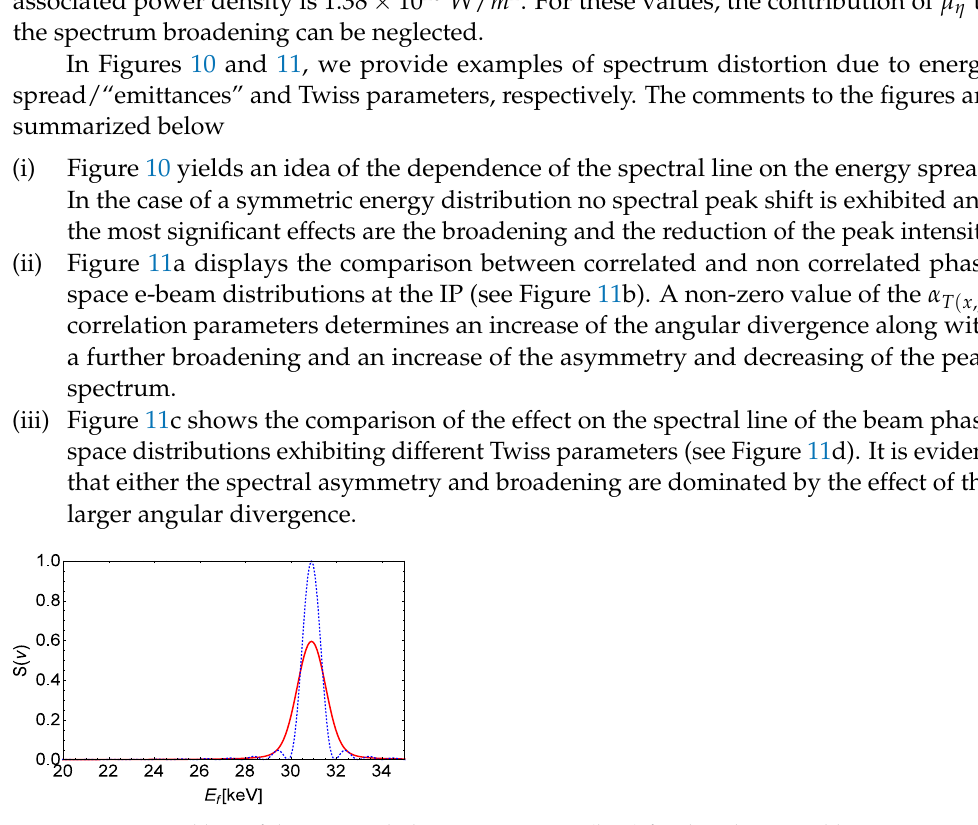
Figure 10. Spectral line of the scattered photons vs. energy (keV) for the e-beam and laser parameters λ l = 1 µ m, (cid:101) N l = 100, γ = 100 and for different values of energy spread and emittance; (continuous) σ ε = 2.5 × 10 − 3 , ε n , x , y = 0 mrad ; (dot) σ ε = 0, ε n , x , y = 0 mrad (The value 0 means that the effect of the emittance has been considered negligible).